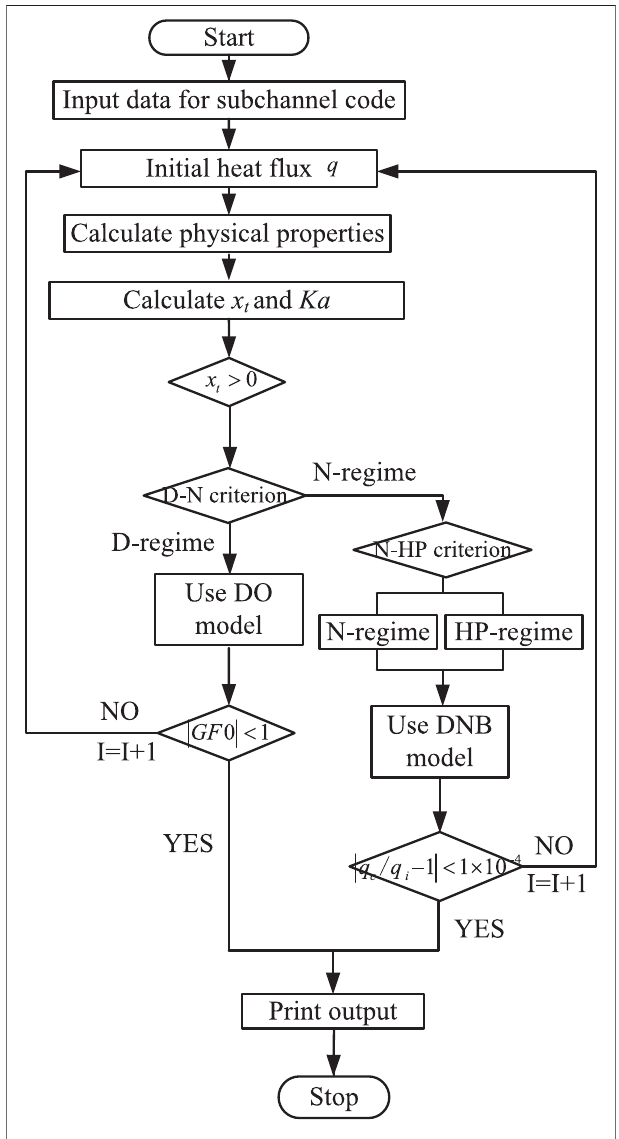
FIGURE 6 | Flowchart of the comprehensive CHF mechanistic